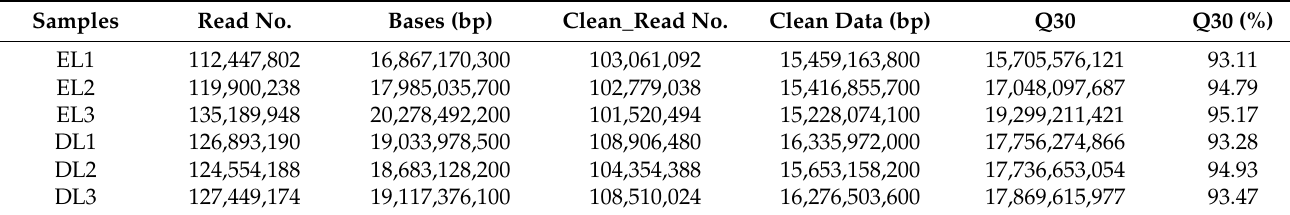
Table 1. Sequencing Data Quality.